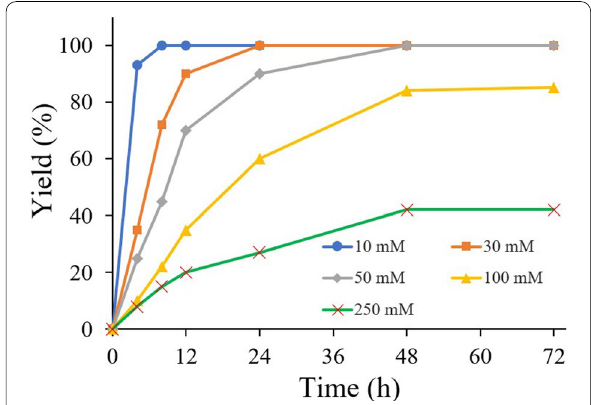
Fig. 3 HLADH– SBFC -catalyzed oxidation lactonization of 1,4-BD at different substrate concentrations. Reaction conditions: NAD